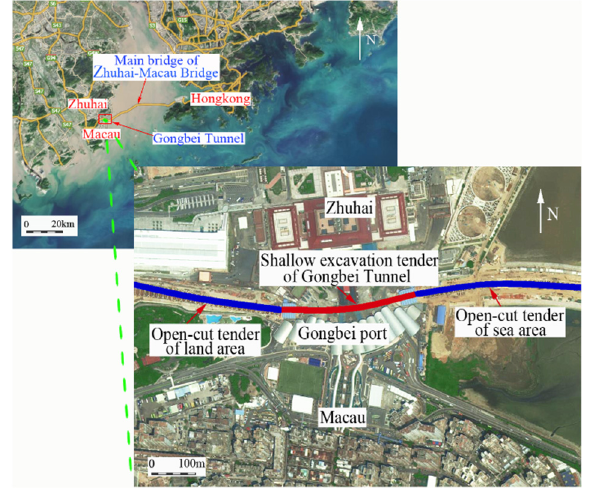
Figure 1 . The alignment of Gongbei tunnel. Figure 2. Geotechnical profile of Gongbei Tunnel shows the geological profile of the Gongbei